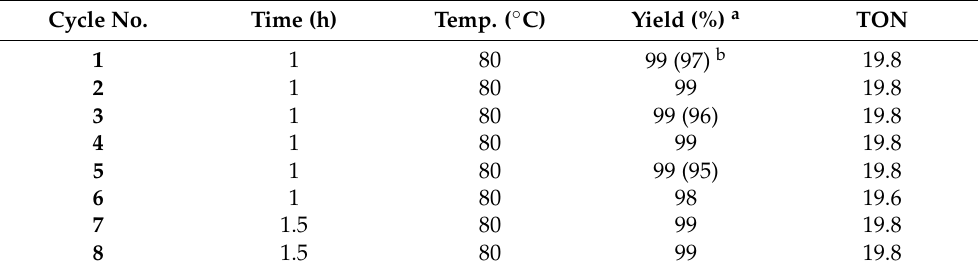
Table 1. Recycling results of A -catalyzed phospha-Michael addition of diisopropyl phosphite ( 1a ) with benzylidenemalononitrile ( 3 ) at 80 ◦ C. Cycle No.